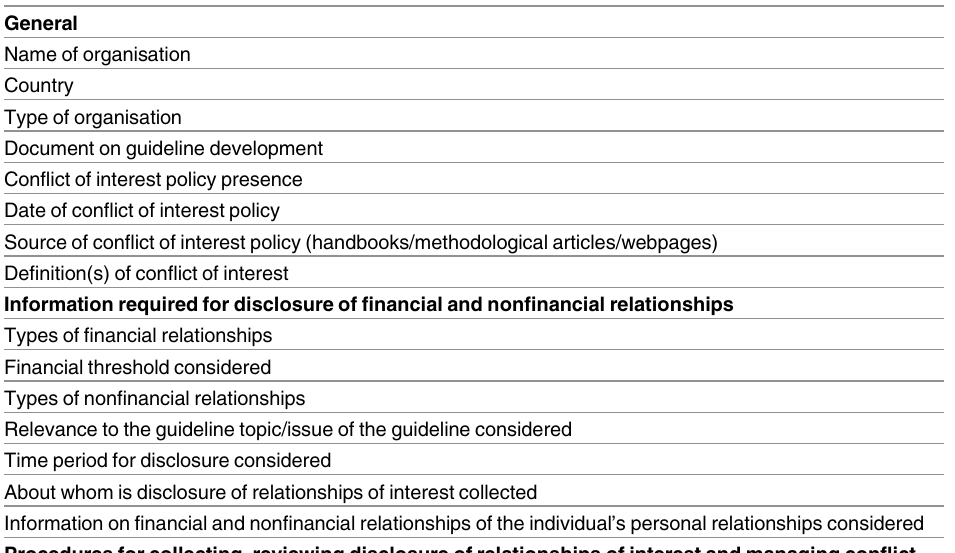
Table 1. Data abstraction